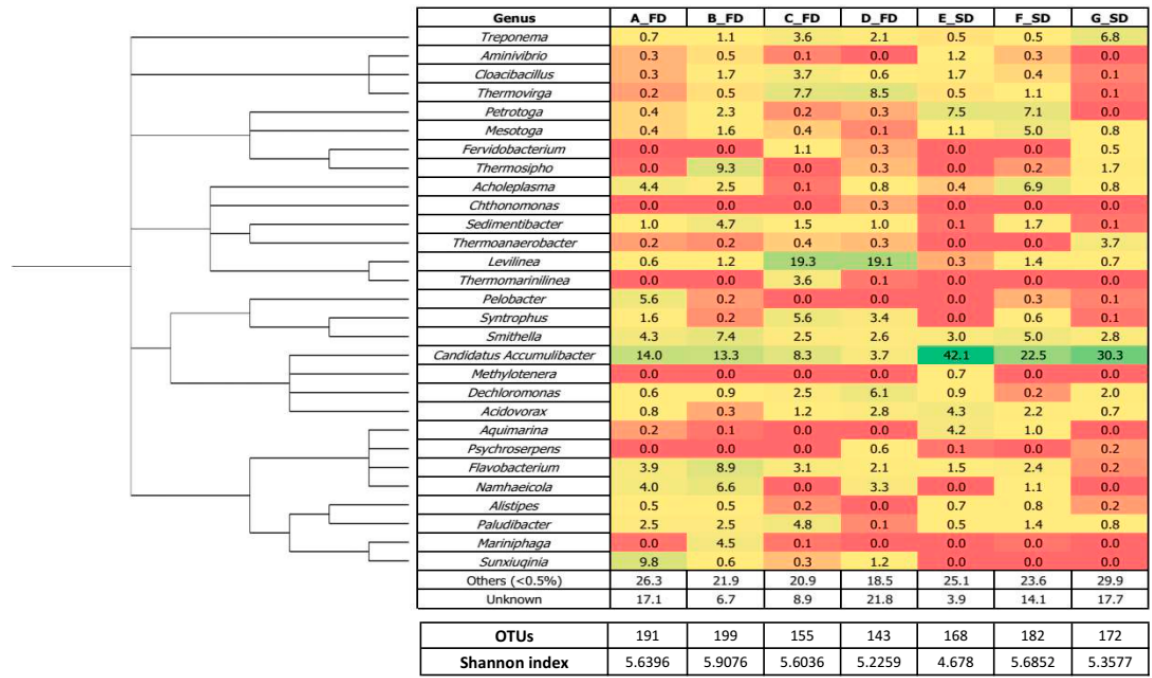
Figure 1. The bacterial genera share and phylogenic tree of seven full-scale anaerobic digestion plants treating food waste and sewage sludge (share ≥ 0.5%) (OTU—operational taxonomic units).